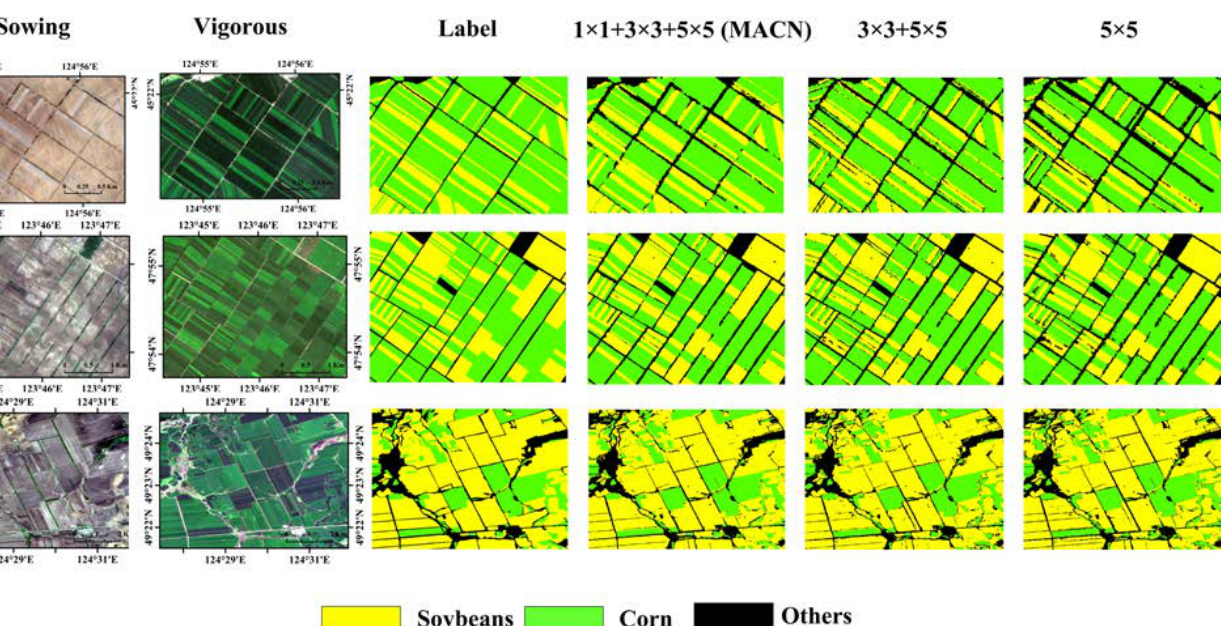
Figure 13. Classification results for different number of branches in the ablation experiment.